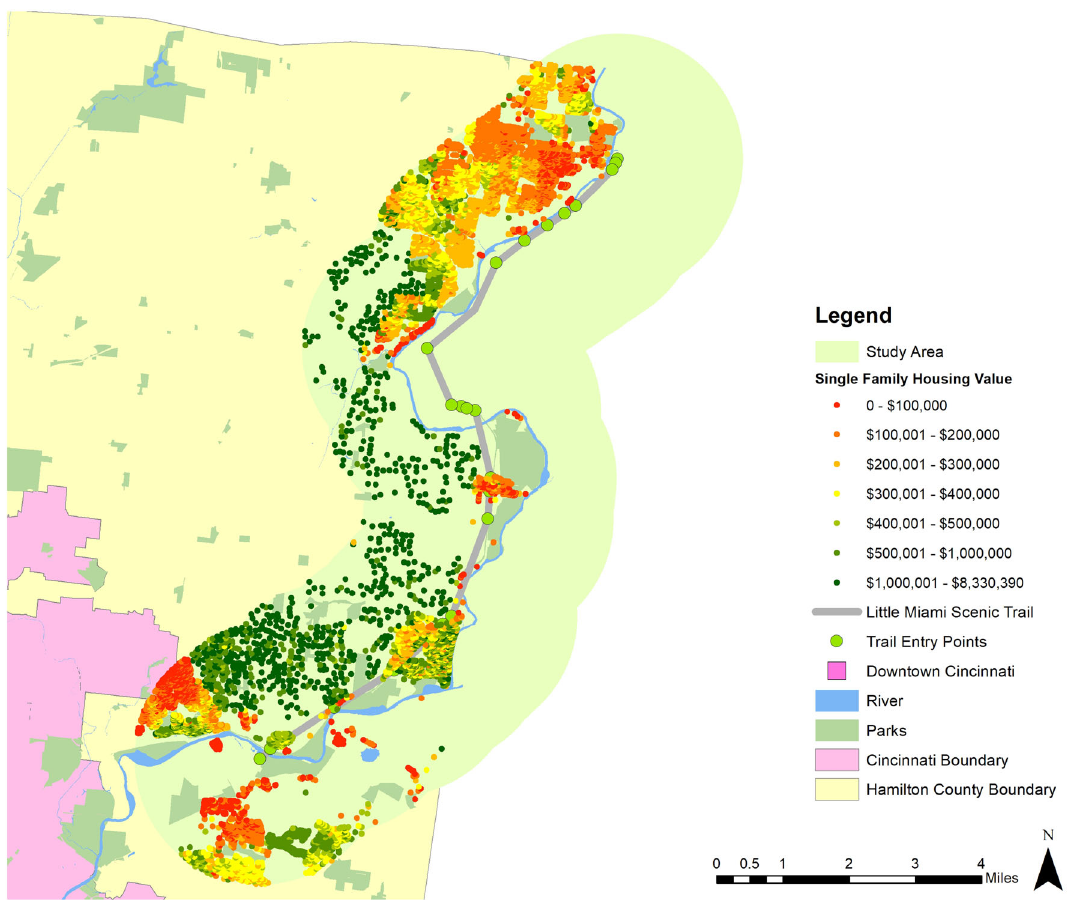
Fig. 2 Detailed map of the study